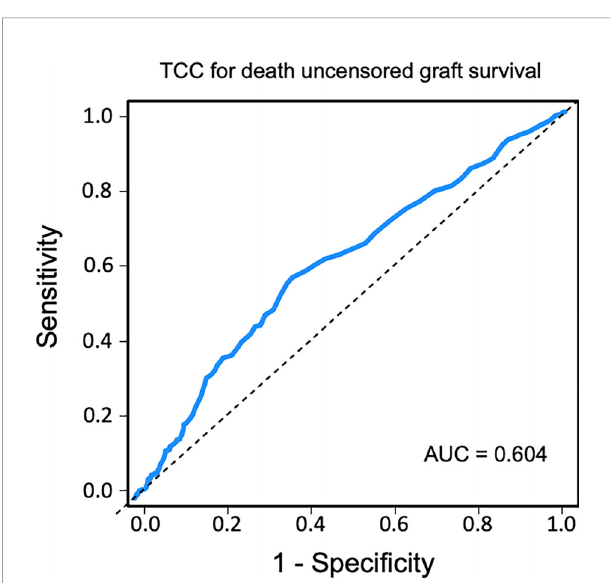
FIGURE 7 | Receiver operating characteristic (ROC) curve analysis of plasma terminal C5b-9 complement complex (TCC) concentration, 10 weeks after transplantation, as a biomarker of uncensored graft survival.